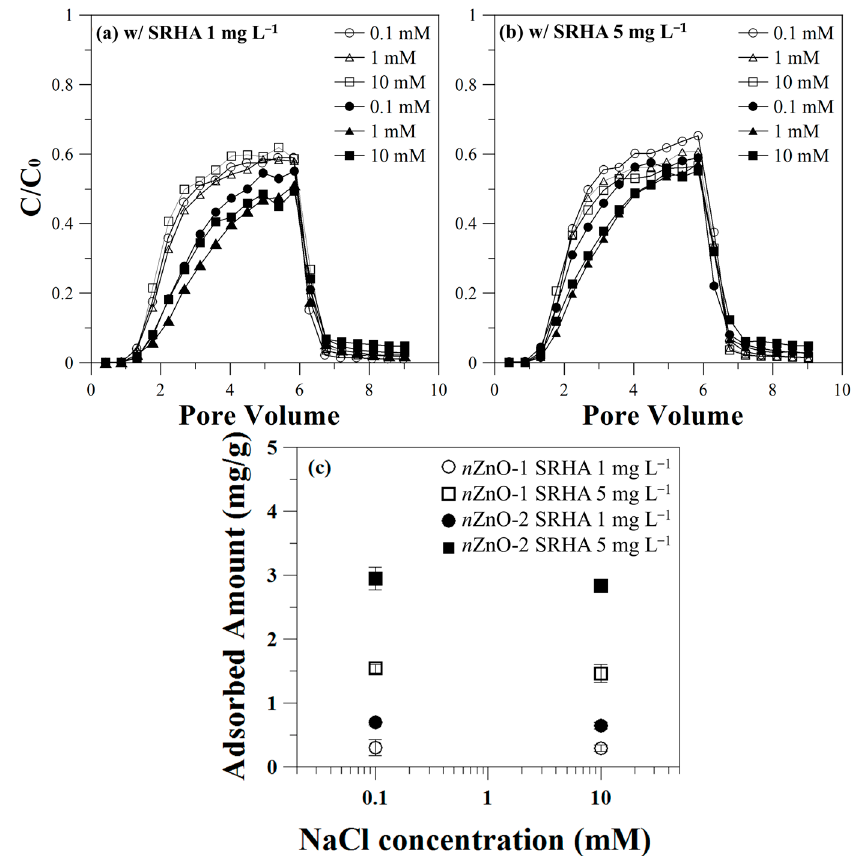
Figure 7. Breakthrough curves of n ZnO-1 (open symbol) and n ZnO-2 (solid symbol) in the presence of SRHA (1 and 5 mg L − 1 for ( a , b ), respectively) at difference ionic strengths in NaCl solution (0.1–10 mM). ( c ) shows the amount of SRHA adsorbed on the n ZnO-1 (open symbol) and n ZnO-2 (solid symbol) surface as a function of solution ionic strength in the presence of an initial SRHA concentration of 1 and 5 mg L − 1 at pH 9.